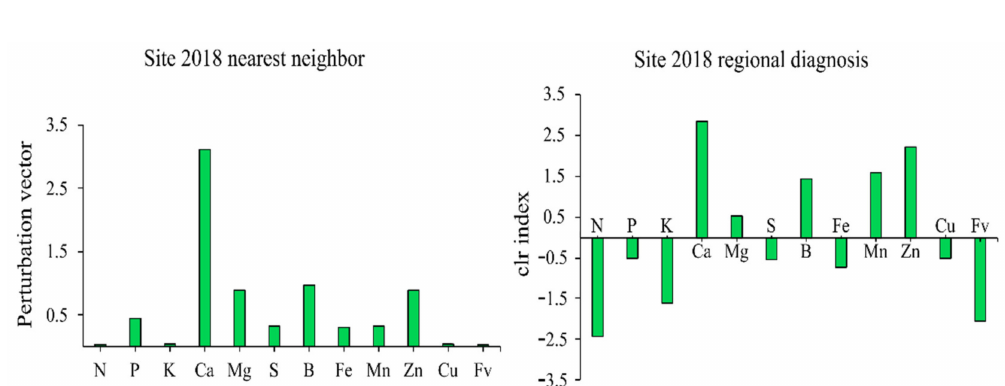
Figure 3. Local diagnosis of a high-yielding false positive specimen against the nearest successful neighbor before and after removing cationic micronutrients. There is a relative excess of Ca, B, S, Mg, and P attributable to luxury consumption. Fv = filling value. Negative differences between defective and successful specimens indicate relative shortage. Positive differences indicate relative